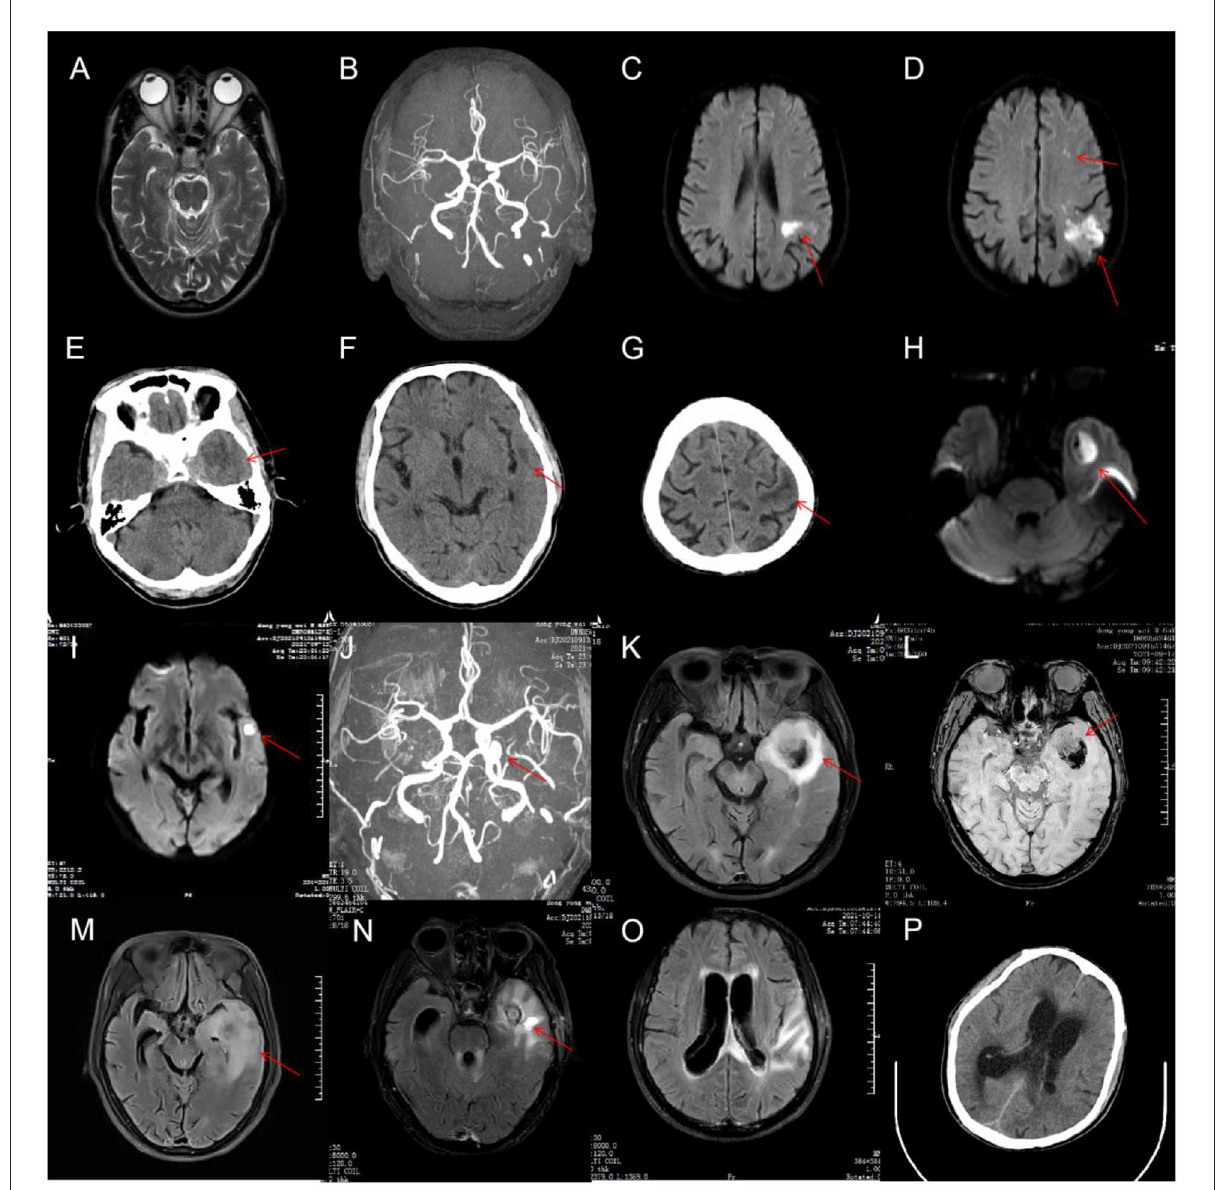
FIGURE1 On admission, cranial magnetic resonance imaging (MRI) of the patient was normal (A) , and there was no evidence of intracranial aneurysm on brain magnetic resonance angiography (MRA) (B) . On hospital day 7, a brain MRI was done again and showed acute multiple cerebral infarcts in the left cerebral hemisphere (C,D) . On hospital day 25, cranial CT revealed significantly increased low-density shadow in the left frontal, temporal, and parietal lobes (E–G) . The MRI (H,I) and MRA (J) re-examination demonstrated that the lesions in the left cerebral hemisphere were increased significantly, and a cerebral aneurysm formed in the intracavernous segment of the left internal carotid artery (ICA). On hospital day 29, a repeat head MRI showed markedly enlarged size of the left temporal lesions with abscess formation and bleeding (K,L) . On hospital day 37, brain MRI showed a decreased size of the left temporal lesions but with perifocal evident edema (M) . On hospital day 55, a repeat head MRI showed that the lesions and edema of the left temporal lobe was improved, but hydrocephalus became even worse (N,O) . On hospital day 58, cranial CT showed intraventricular extension and hydrocephalus (P)